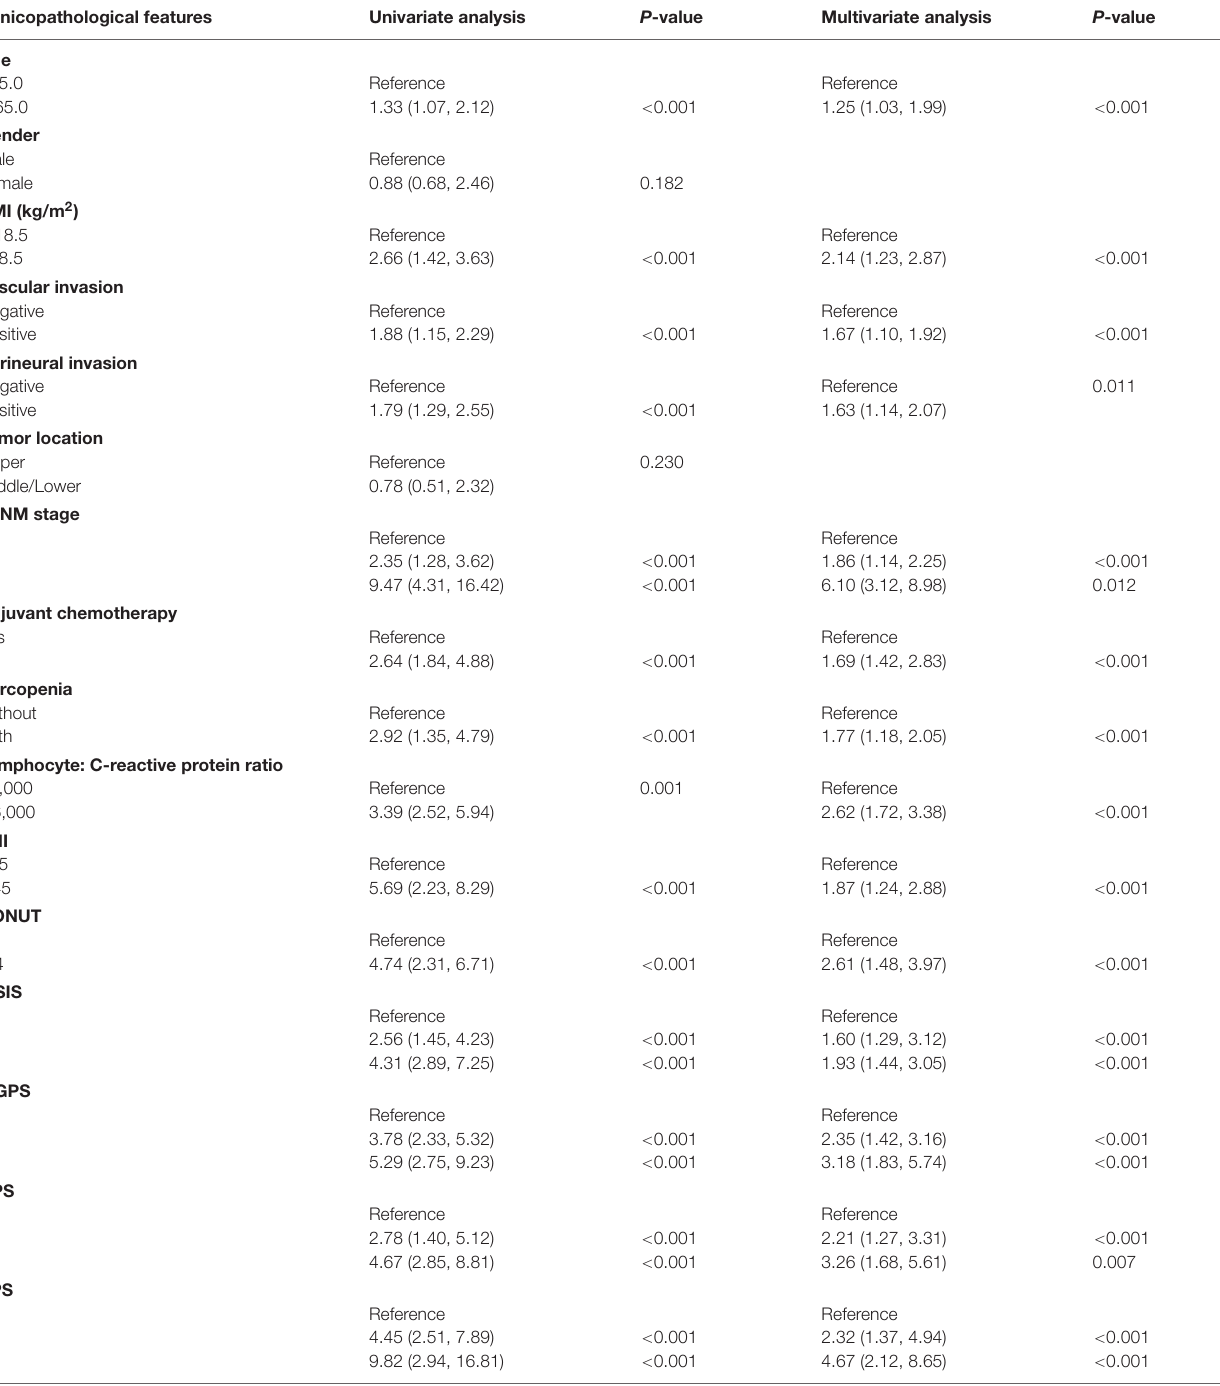
TABLE 2 | Univariate and multivariate analysis of clinicopathological variables in relation to overall survival in patients with gastric cancer (discovery cohort). Clinicopathological features Univariate analysis P -value Multivariate